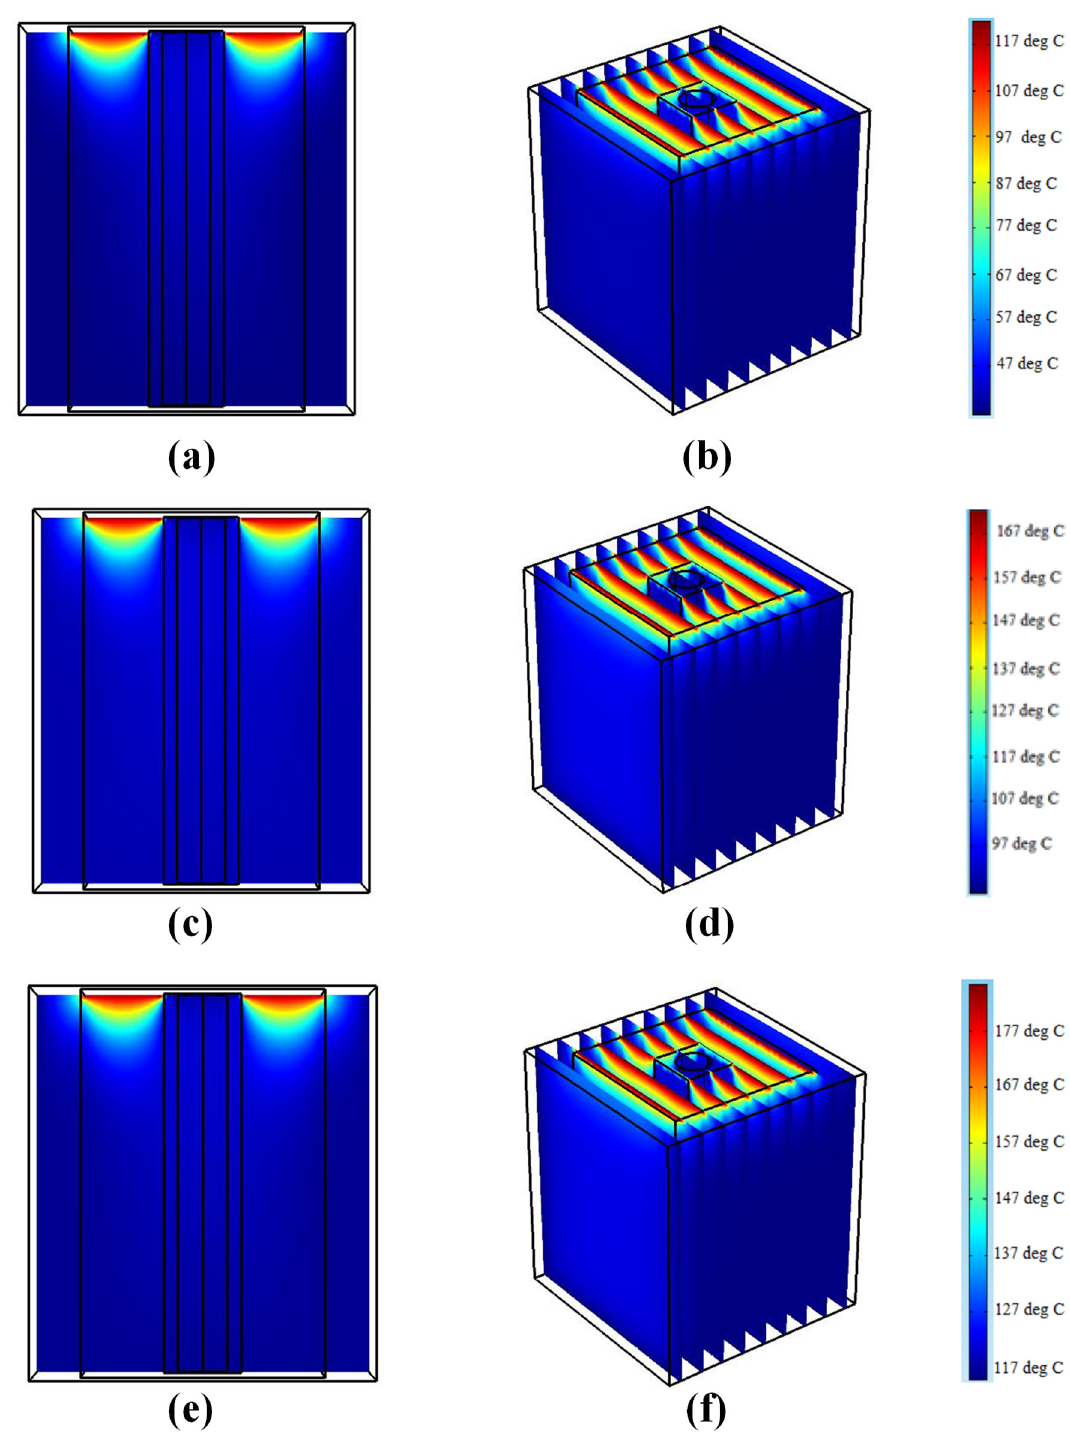
Figure 18. Temperature profile on ( a ) center plane and ( b ) multiple slices along the yz-axis after 800 ( c ) center plane and ( d ) multiple slices along the yz -axis after 1600 s; ( e ) center plane and ( f ) multiple s; ( c ) center plane and ( d ) multiple slices along the yz-axis after 1600 s; ( e ) center plane and ( f ) mul- slices along the yz -axis after 2400 tiple slices along the yz-axis after 2400 s.